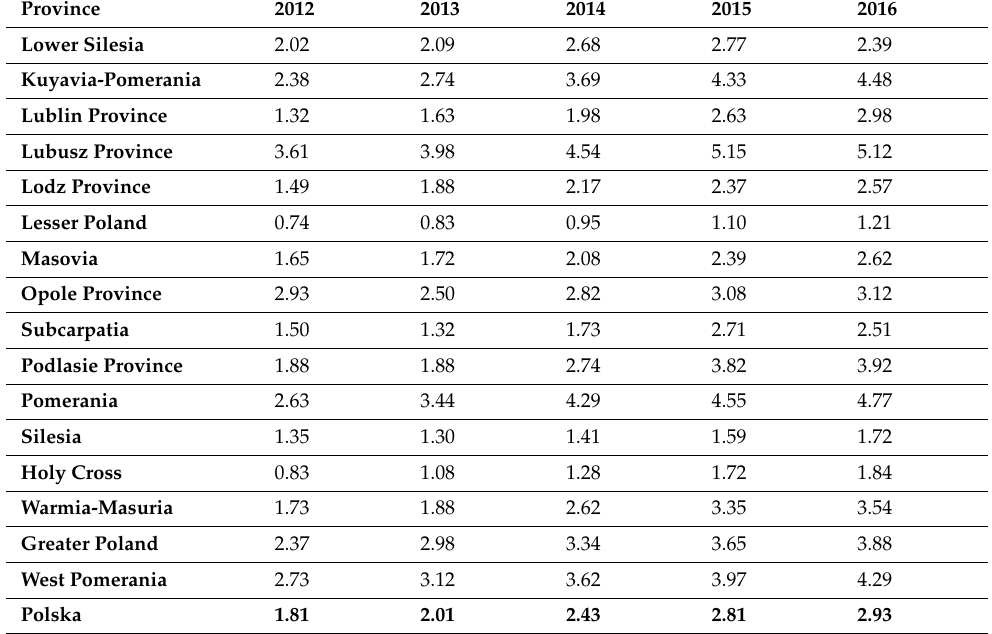
Table 5. Bicycle roads of Poland per 10,000 inhabitants in years